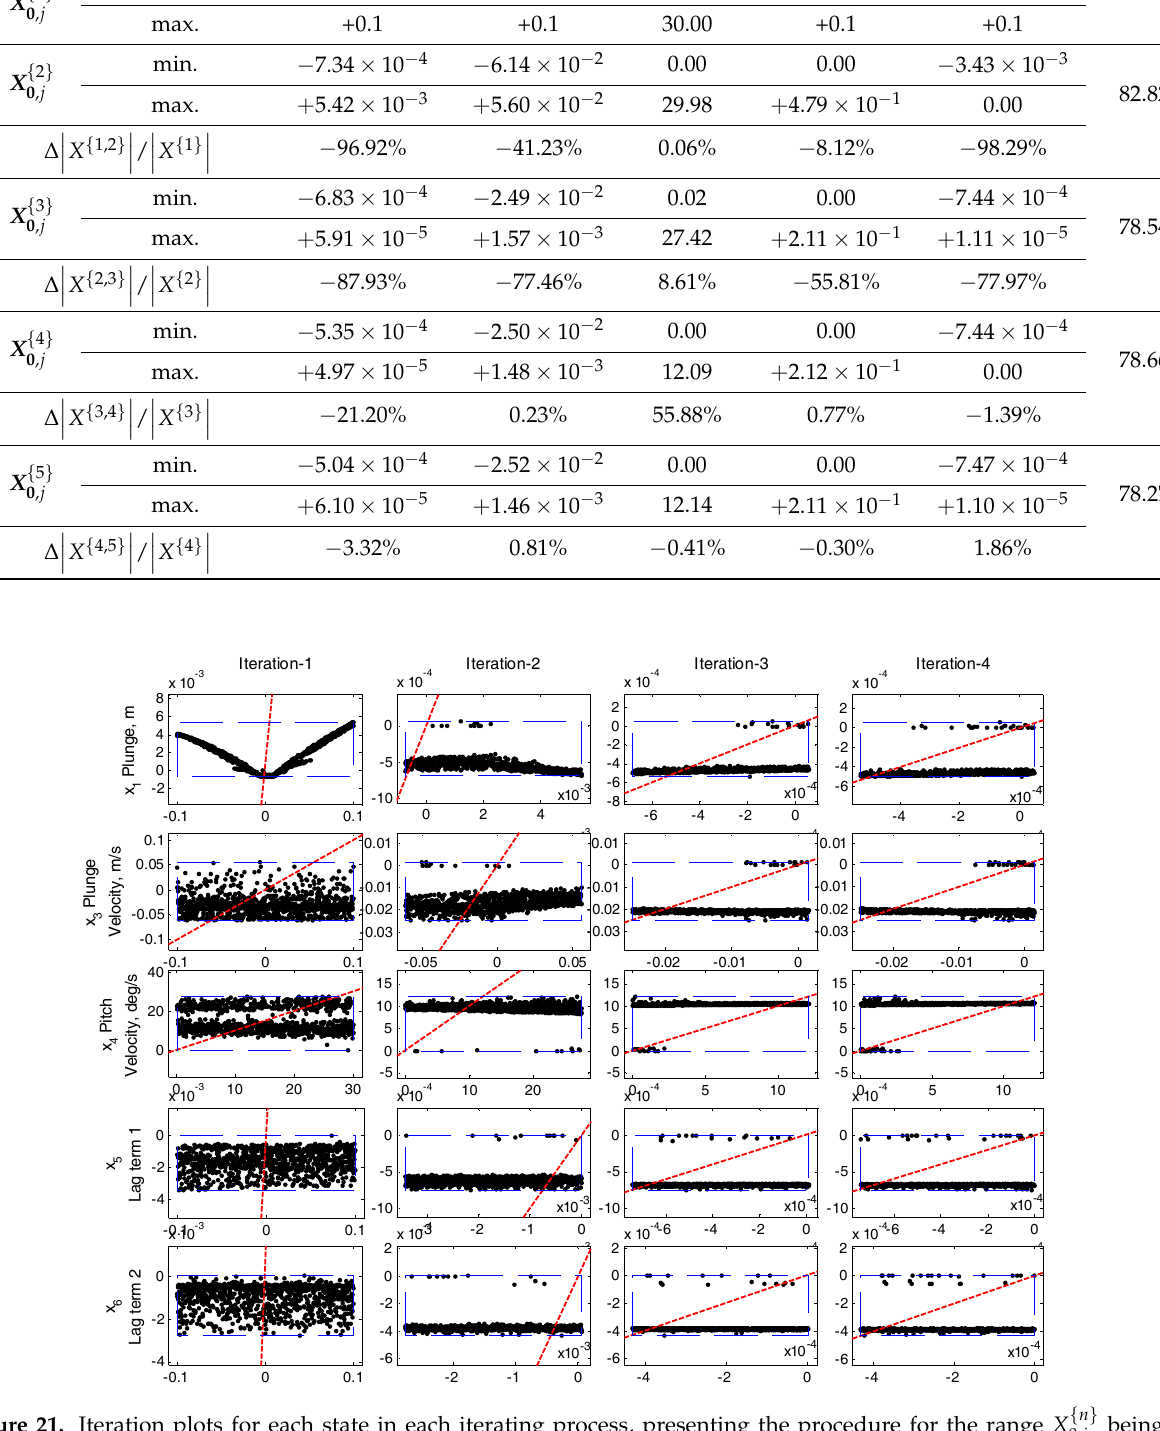
Figure 21. Iteration plots for each state in each iterating process, presenting the procedure for the range (cid:1850) (cid:2868),(cid:3037){(cid:3041)} being con- tracted to (cid:1850) (cid:2868),(cid:3037){(cid:3041)(cid:2878)(cid:2869)} . Each one of the subplots in this figure is similar to that in Figure 20. After Iteration-4, clear spatial patterns emerge on each of the five iteration plots, as shown in the rightmost column of Figure 21. For example, we can focus on the iteration x , which is located at the third row and fourth column in Figure 21, and re- plot for 0,4 plot it in Figure 22. Three fixed points can be easily distinguished: one is at deg/s, one is at